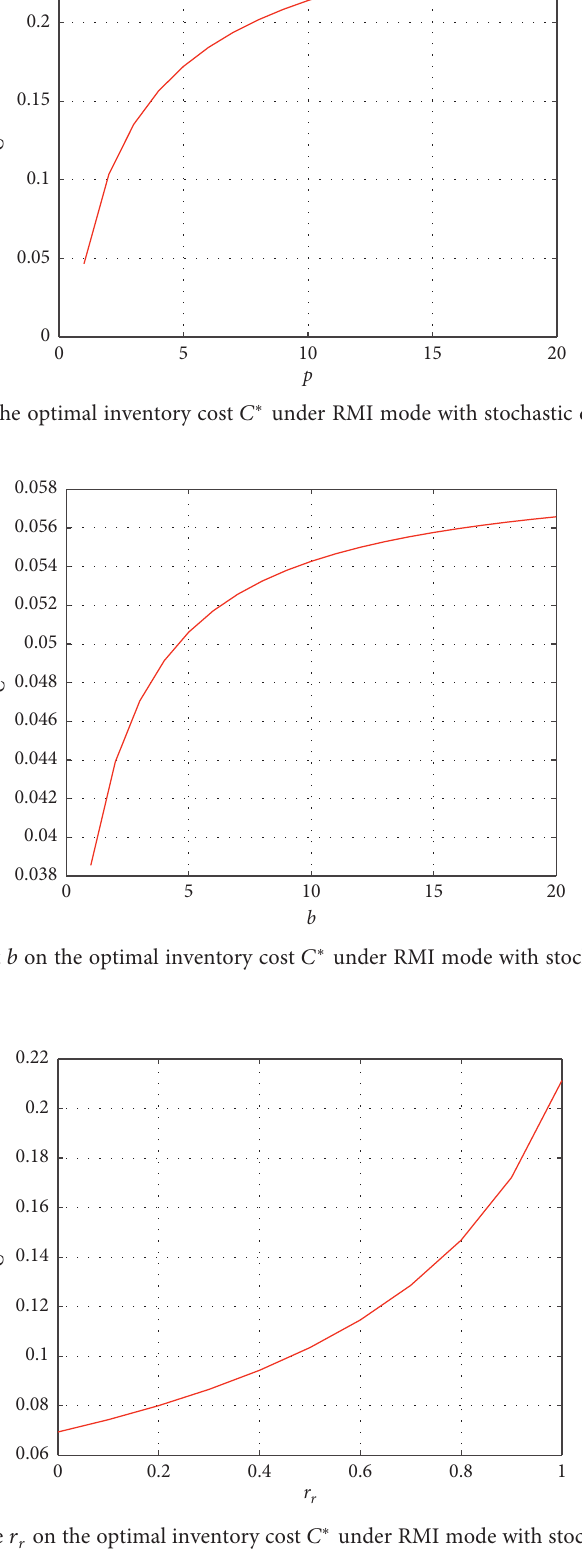
r on the optimal inventory cost